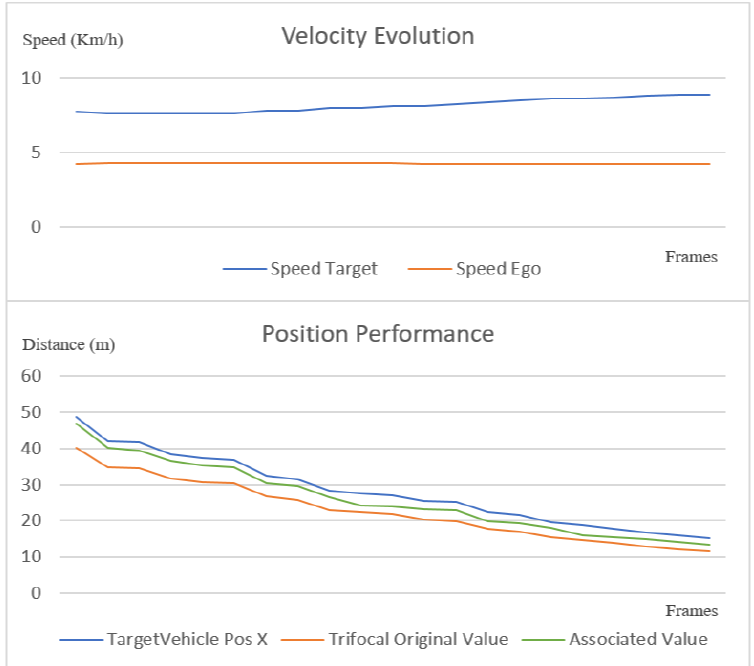
Figure 20. Speed chart (top) and position chart (bottom) of a trifocal object association scenario.